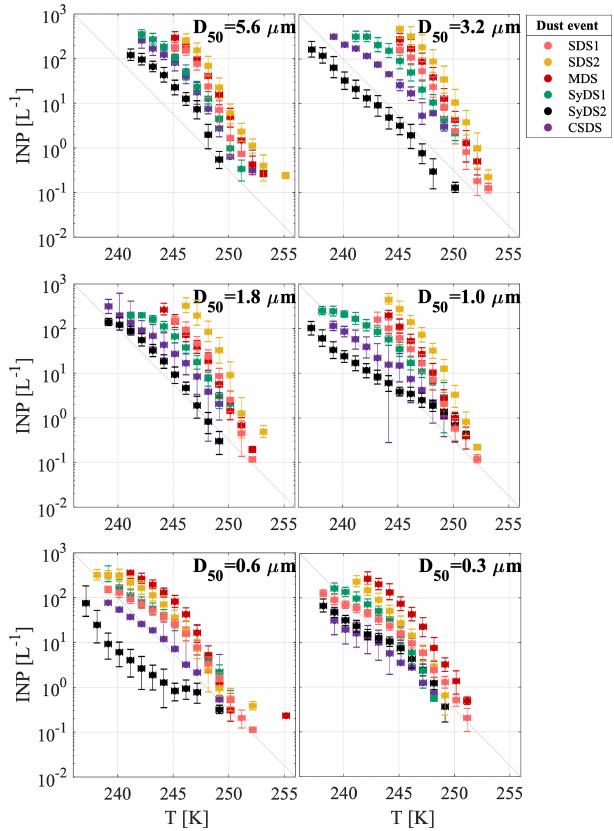
Figure 5. Airborne INP concentrations for various size classes. INP concentrations per liter of air as a function of temperature are pre- sented in different colors for the different dust events that were sam- pled. Uncertainty in temperature is 0.3K. The grey diagonal line is presented for orientation only.